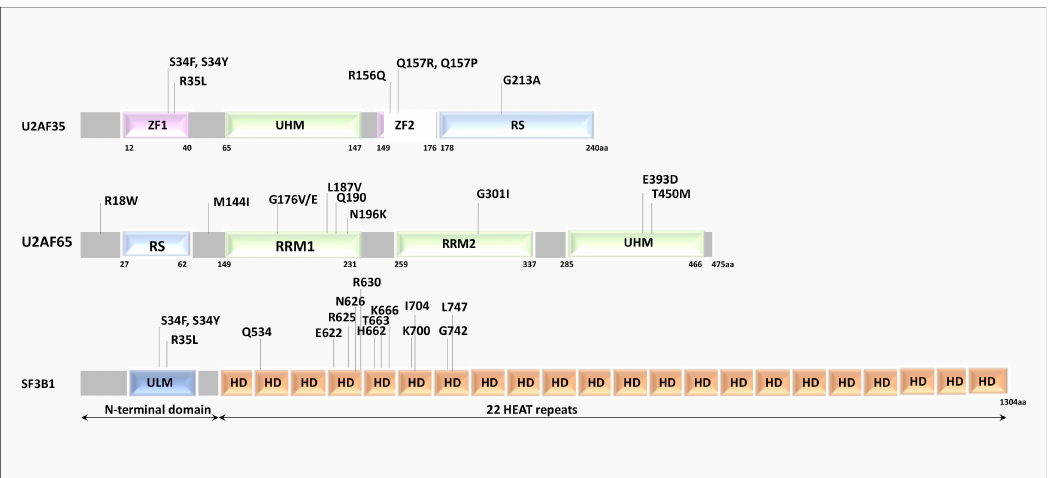
Figure 2. U2AF35, U2AF65, and SF3B1 mutations in an individual with hematological malignancies. Schematic representation of U2AF35, U2AF65, and SF3B1 protein domains and recurrent somatic mutations identified in cancer patients within each domain. ZF, zinc finger; UHM, U2AF homology motif; RS, Arginine Serine domain; RRM, RNA-recognition motif; ULM, U2AF ligand motif; HD, HEAT (Huntingtin, Elongation factor 3, protein phosphatase 2A, Targets of rapamycin 1)